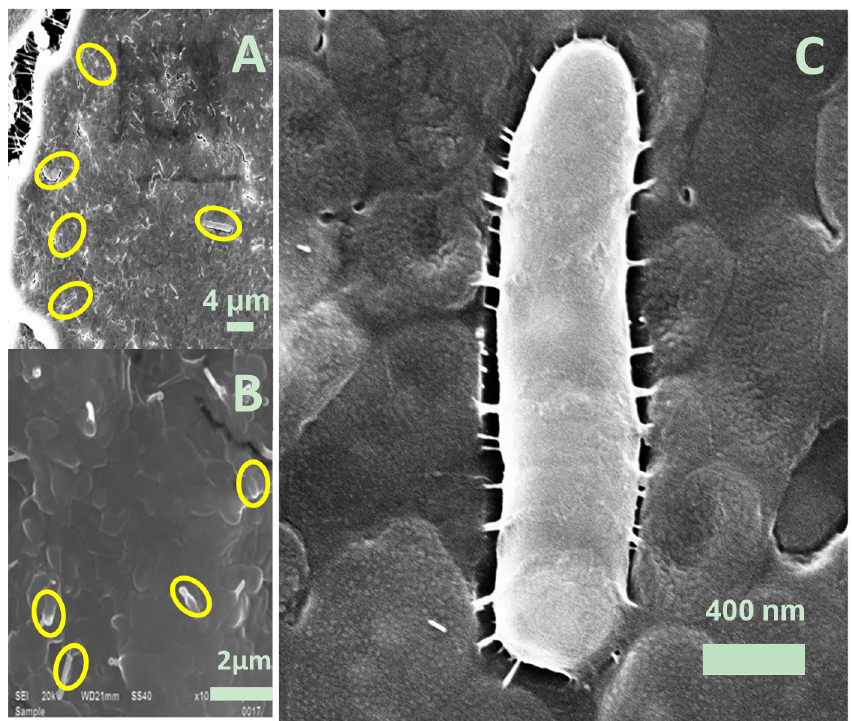
Figure 3. SEM images of increasing magnification of anodes evaluated in an MEC for 2 weeks and inoculated with Shewanella oneidensis MR-1. Images of carbon nanofiber mat/CNF images of increasing magnication ( A , B ); A magnified image of a single bacterium, set in a biofilm, found on the CNF electrode is also shown ( C